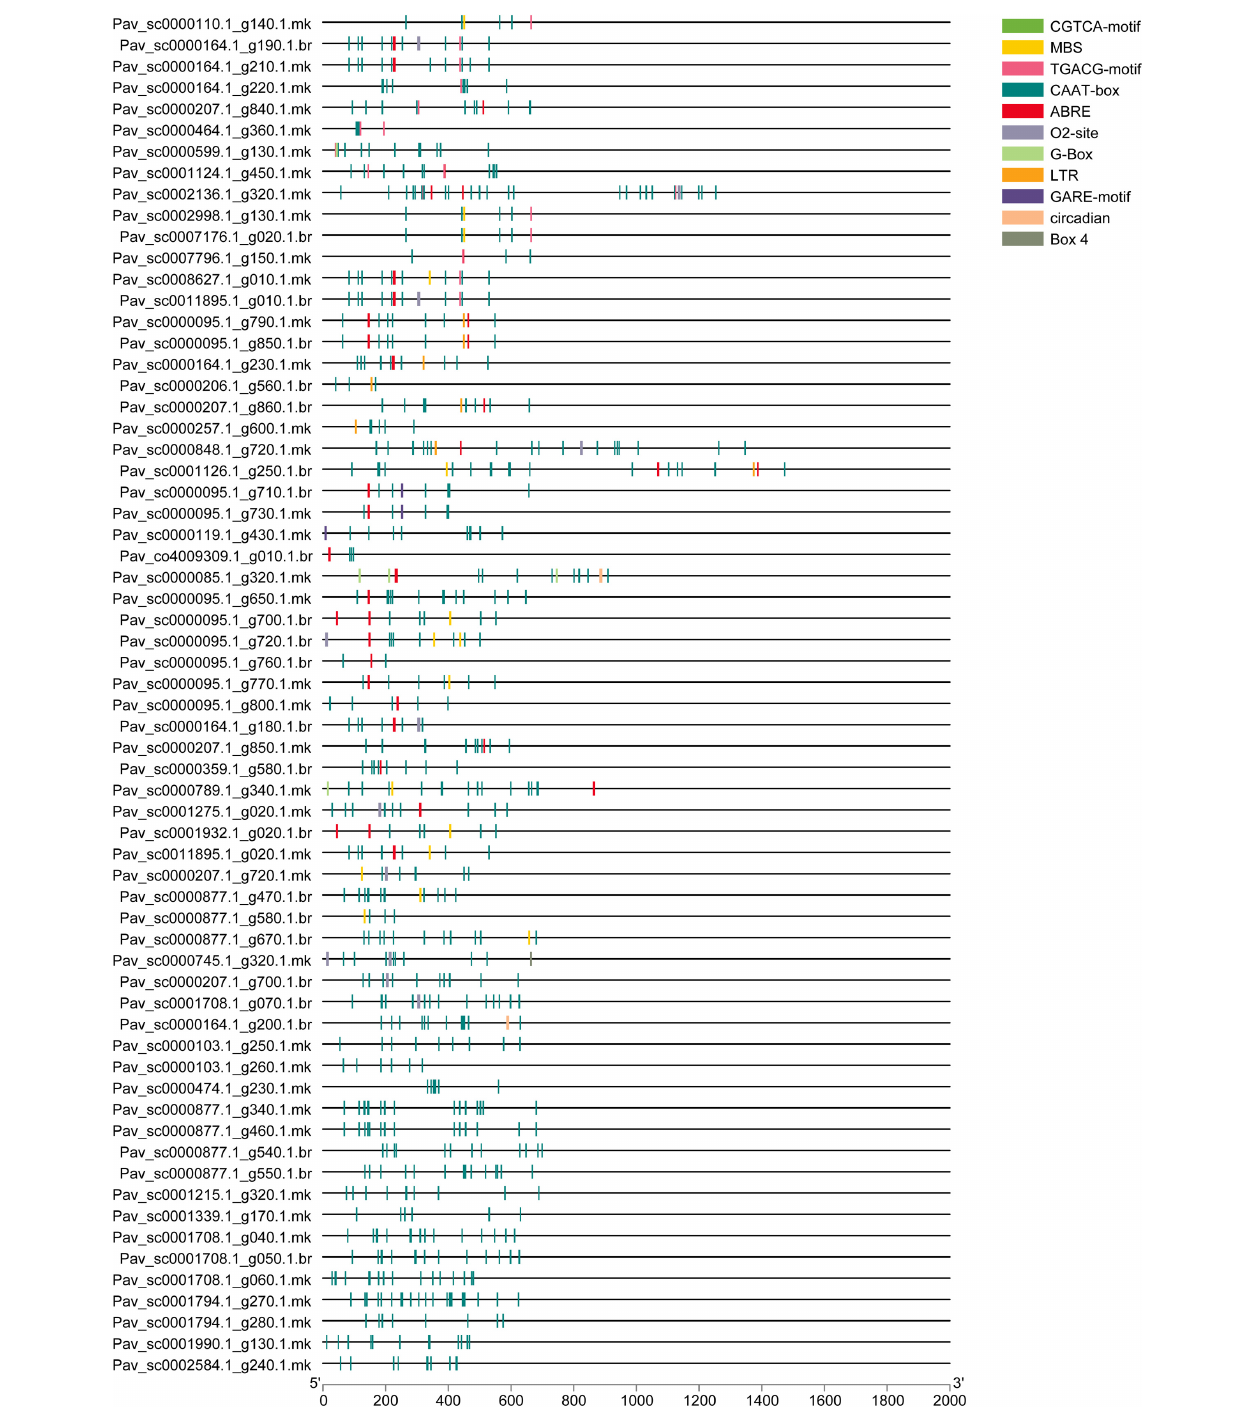
FIGURE 3 | Identified cis -elements in the promoter regions of the PavGST genes. All promoter sequences (2 kb) were assessed. The PavGST genes are depicted on the left side of the figure. The scale bar at the bottom represents the length of promoter sequence.